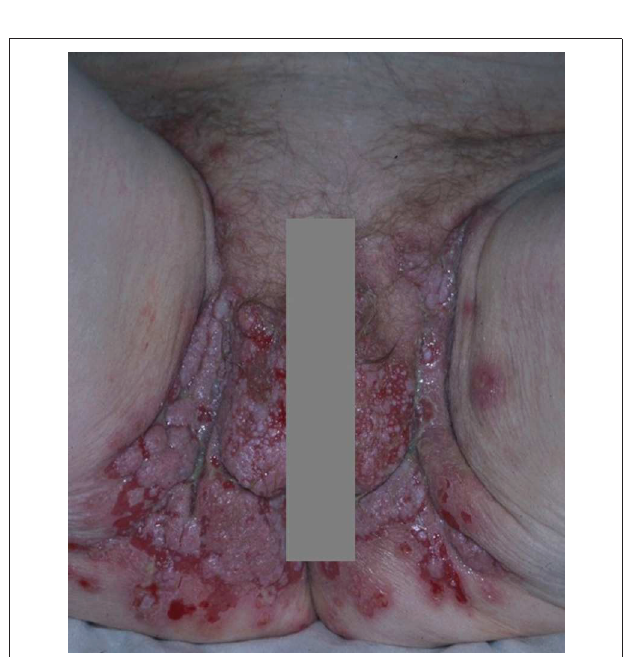
FIGURE 2 | Pemphigus vegetans: vegetative lesions and erosions of the groin and genitals.